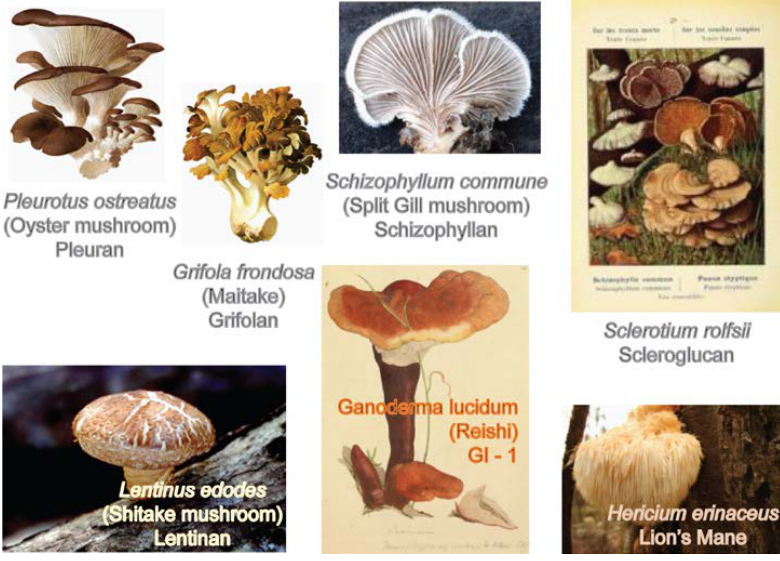
Figure 3. Mushrooms containing β -(1 → 3)-glucans with β -(1 → 6) branching).